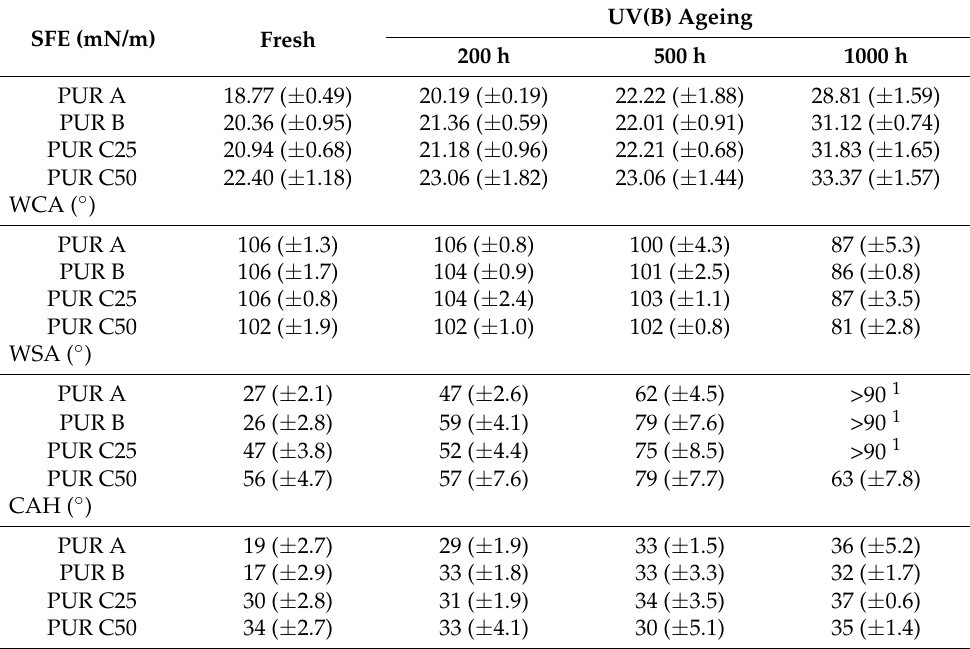
Table 3. Wettability of surfaces—initial and after UV(B) ageing—with surface free energy (SFE), water contact angle (WCA), water sliding angle (WSA), and contact angle hysteresis (CAH). Mean of threefold measurement on a minimum of two test samples ± standard